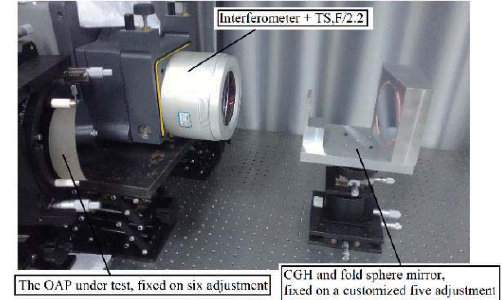
( d ) Figure 10. ( a ) Simulated residual wavefront of the hybrid compensation method (test CGH) in Zemax (PV = 0.0001 λ ); ( b ) simulation pattern of the customized CGH for this hybrid compensation system; ( c ) CGH photograph; ( d ) error of the fold sphere mirror (PV = 0.054 λ ). During the measuring process, the customized CGH was placed close to the fold sphere mirror